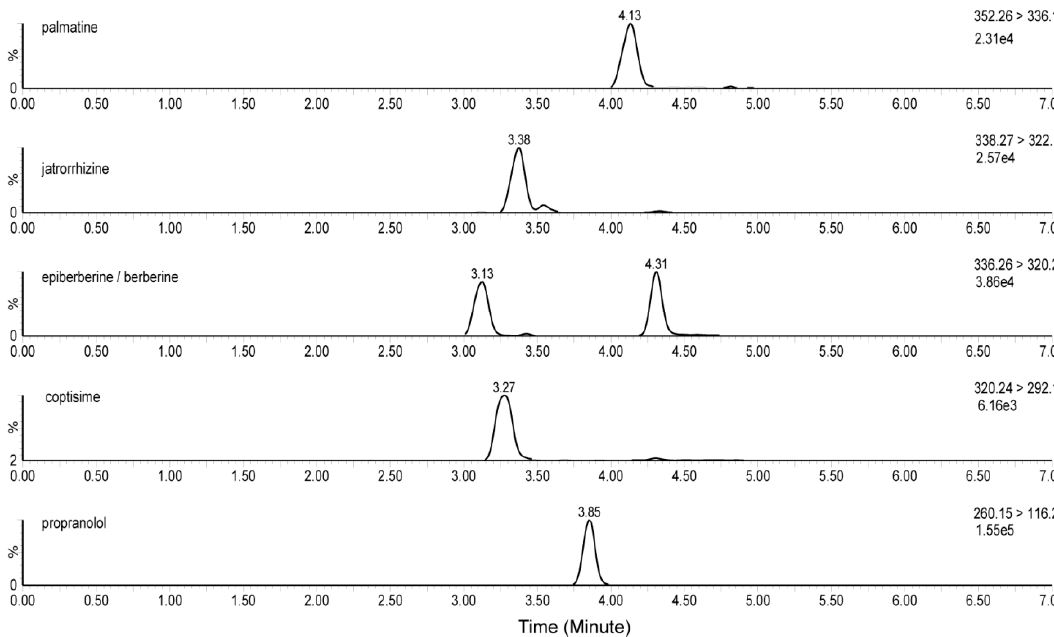
Figure 3. Representative MRM chromatograms of palmatine, jatrorrhizine, epiberberine, berberine, coptisine, and IS in plasma collected 2 h after oral administration of JinQi Jiangtang (JQJT).